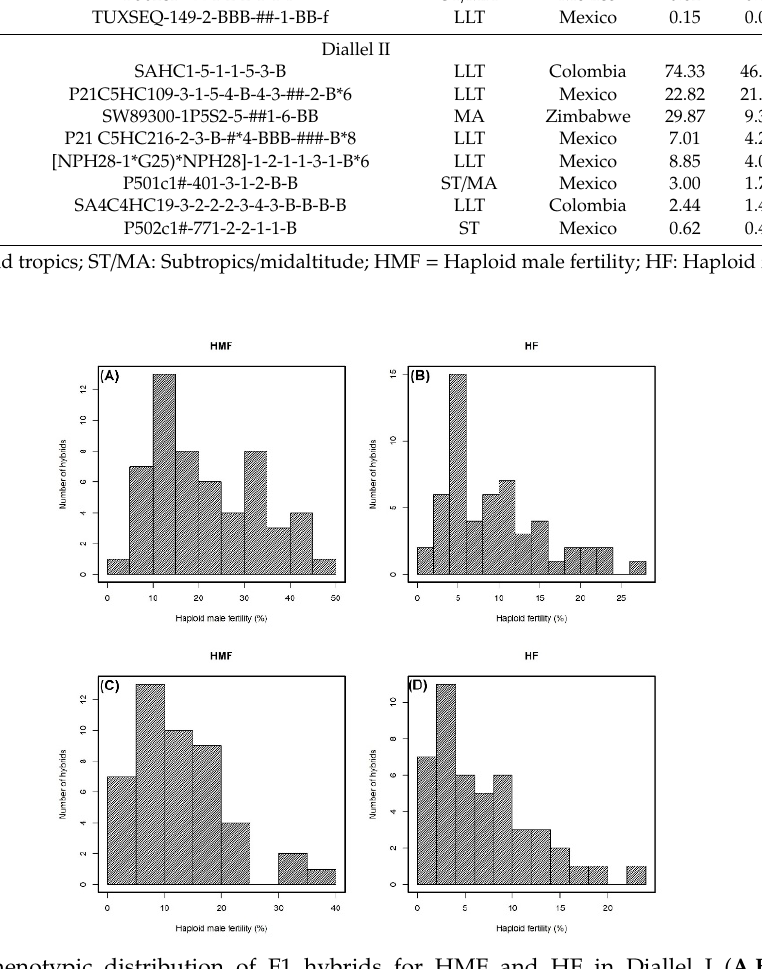
Figure 2. Phenotypic distribution of F1 hybrids for HMF and HF in Diallel I ( A , B ) and II ( C , D )